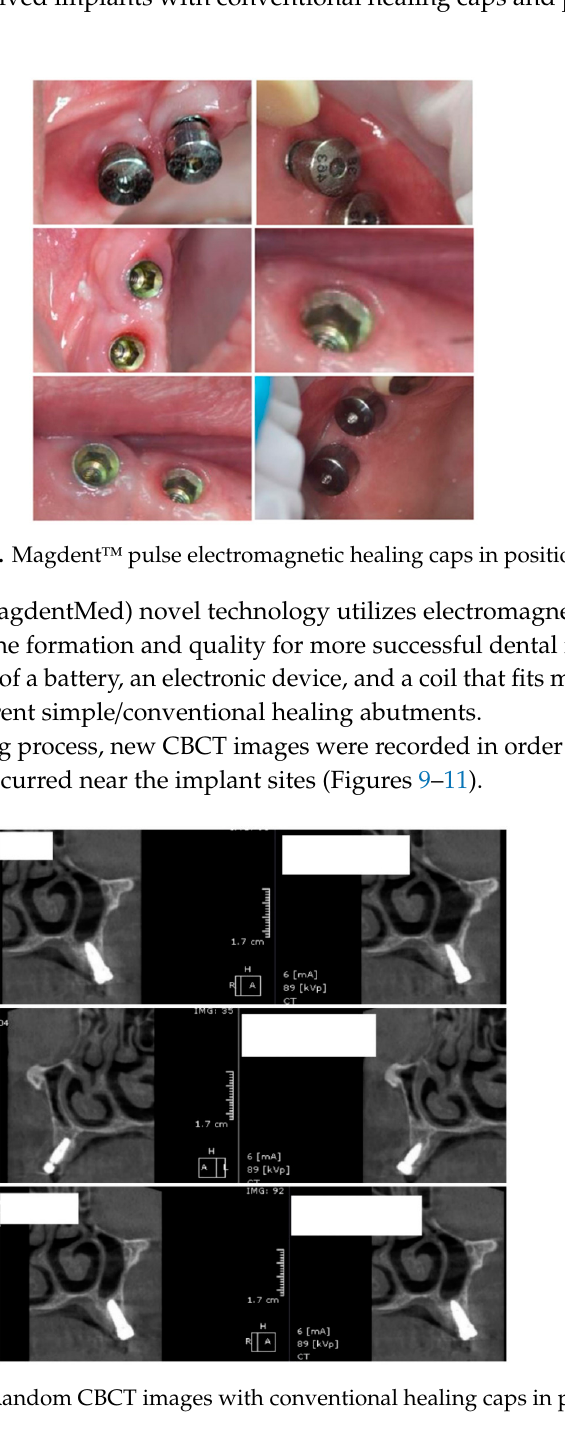
Figure 9. Random CBCT images with conventional healing caps in place.